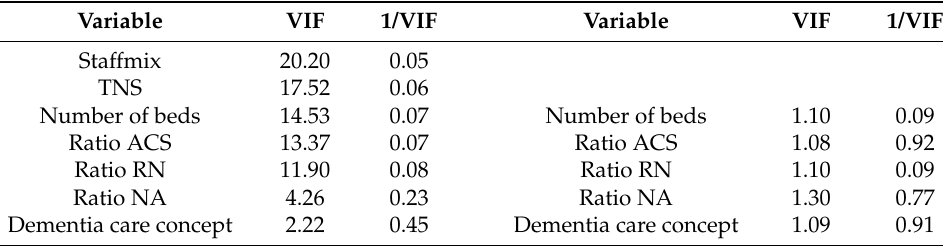
Table A1. Multicollinearity.